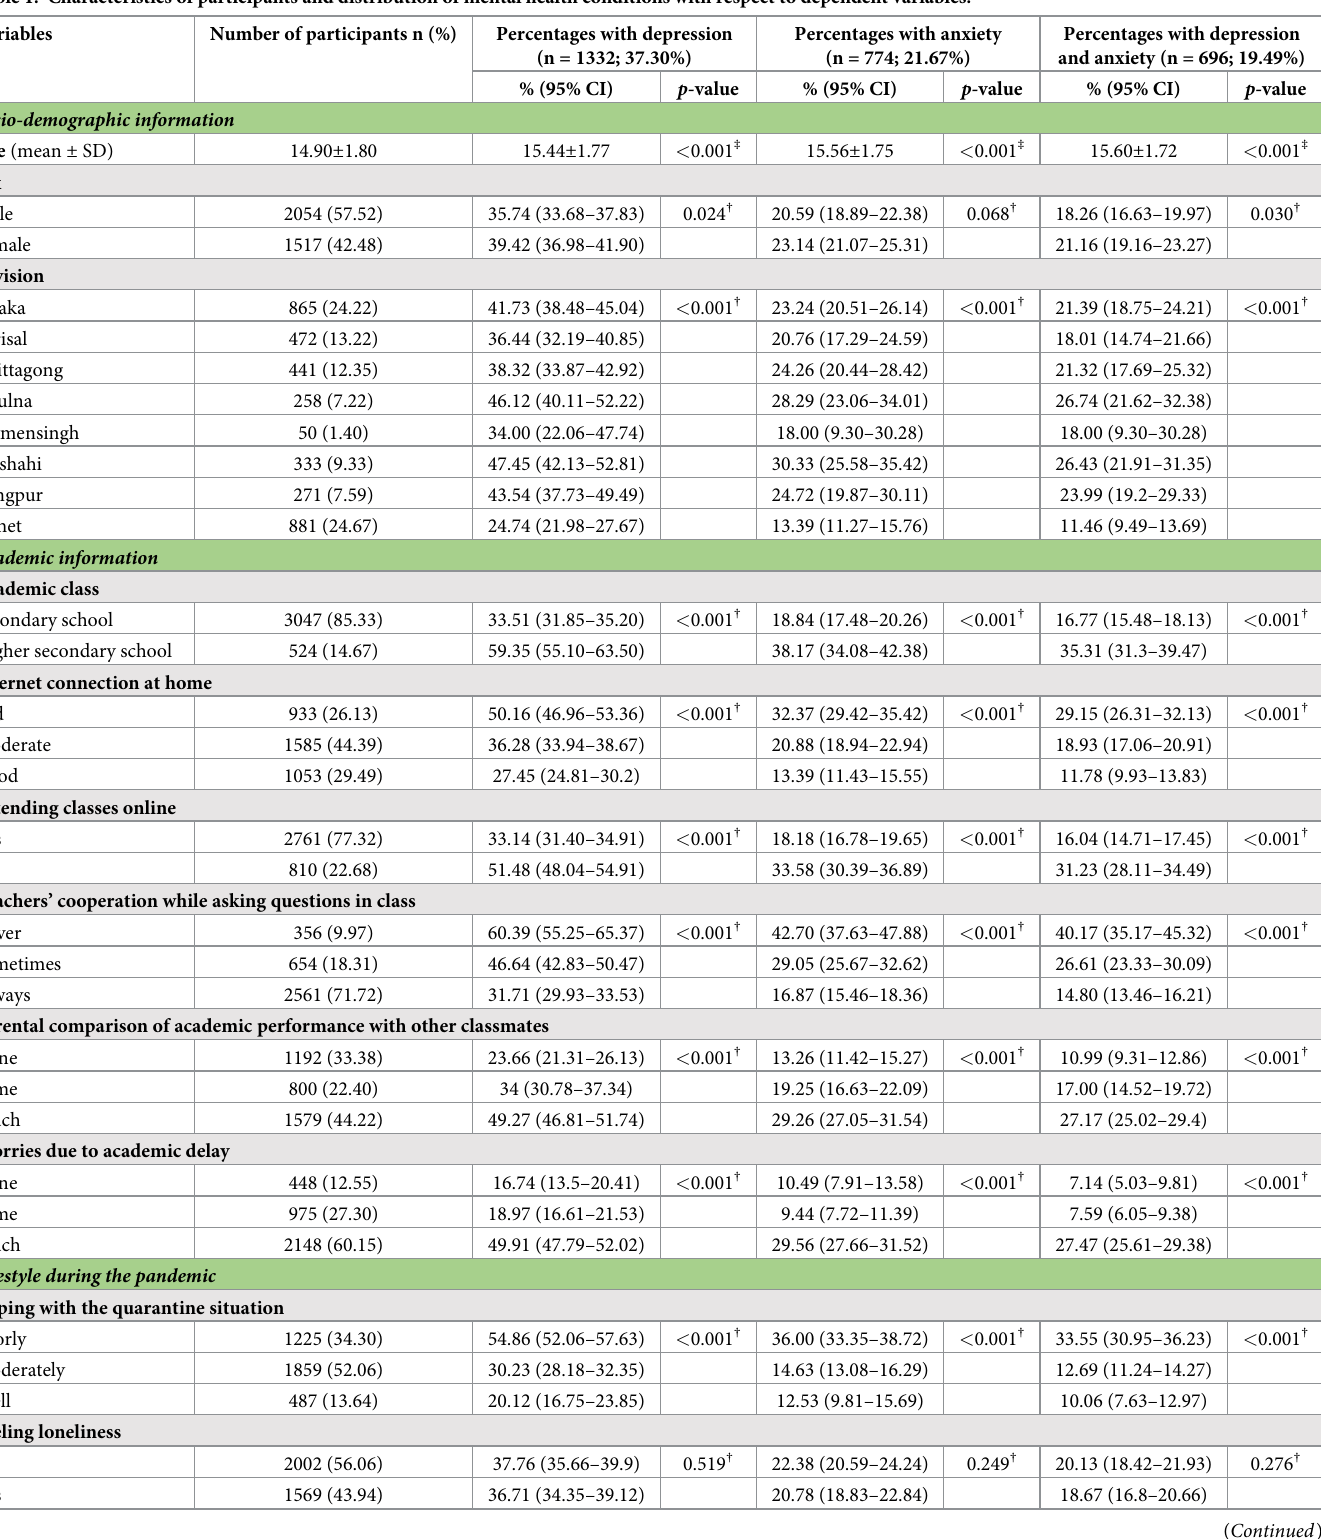
Table 1. Characteristics of participants and distribution of mental health conditions with respect to dependent